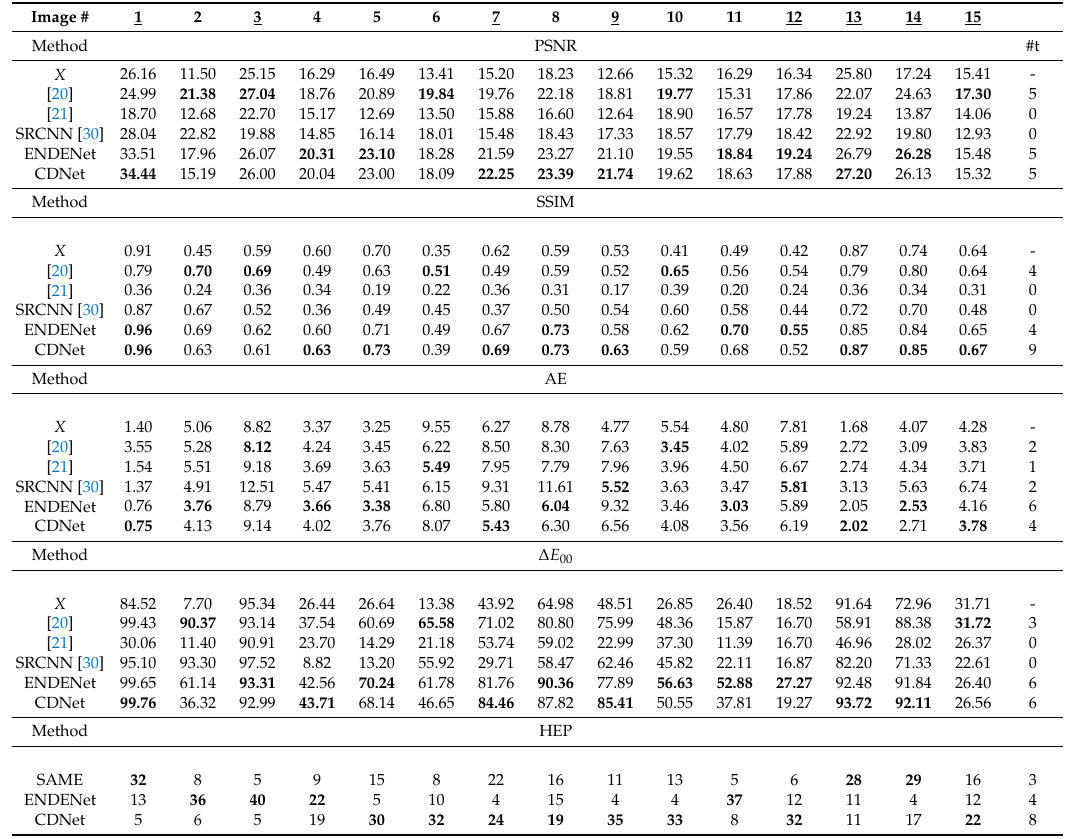
Table 2. Results for a subset of 15 images from [16] (images selected as detailed in Section 4). The underlined images are depicted in Figures 5 and 6 for qualitative evaluation. Bold values correspond to the best performance in the given similarity measurement; #t corresponds to the number of times a given algorithm obtained the best performance. The last section (HEP) contains the results from the survey; each value corresponds to the number of users that selected this result as the best one. ”SAME” is used when the output from both architectures was the same for a given